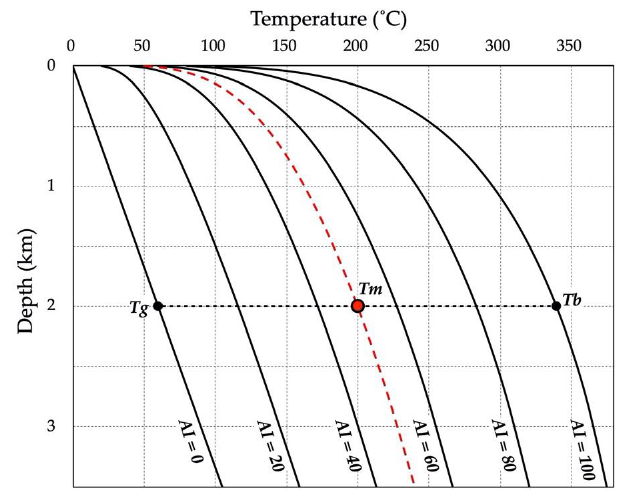
Figure 1. Calculation of the activity index (AI), and estimation of the temperature curve using the activity index. Six black solid curves show AI = 0, AI = 20, AI = 40, AI = 60, AI = 80, and AI = 100, respectively. The red dotted line shows the temperature curve estimated using the activity index.